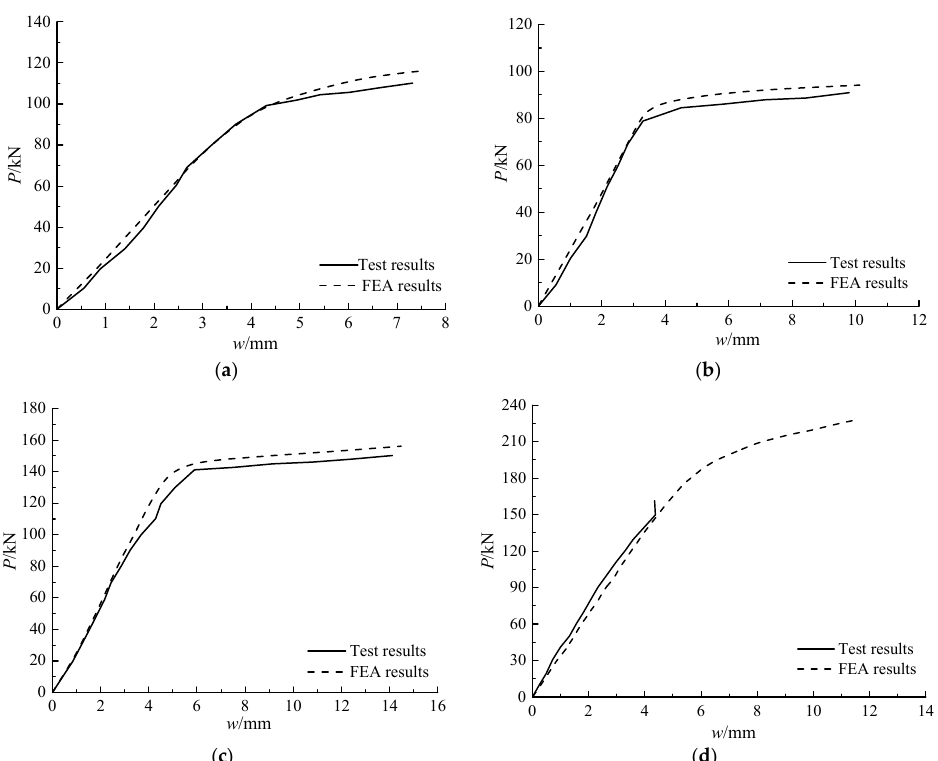
Figure 16. Comparison of experimental and finite element analysis vertical load–midspan vertical deflection curves. ( a ) T-HW; ( b ) T-HN; ( c ) TS-AS; ( d ) TS-FC.